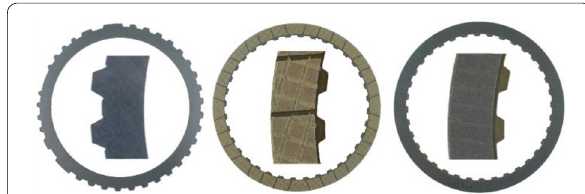
Figure 12 Test parts—steel plate (left), friction plate with DCT friction material (middle), friction plate with AT friction material (right)